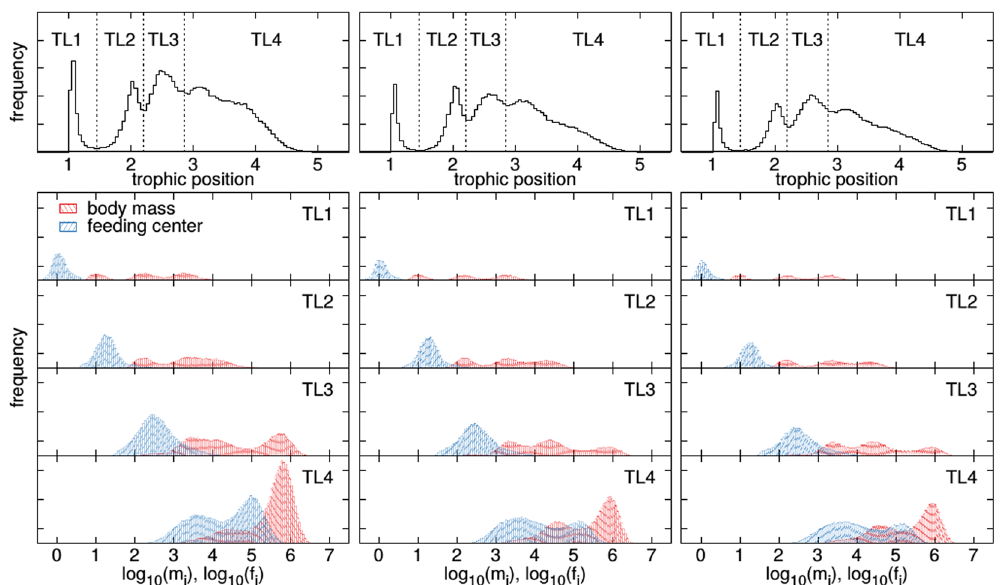
Figure 4. Properties of successful mutants: Top panels show the flow-based trophic positions of mutants in a single habitat (left panel), two habitats with migration from start (scenario 1, middle panel) and two habitats with migration after initial build-up (scenario 2, right panel). We use these distributions to group the morphs into 4 different trophic levels. The body masses and the feeding centers of the mutants in these levels are shown in the other panels. The data is normalized by the total number of mutants and includes only viable